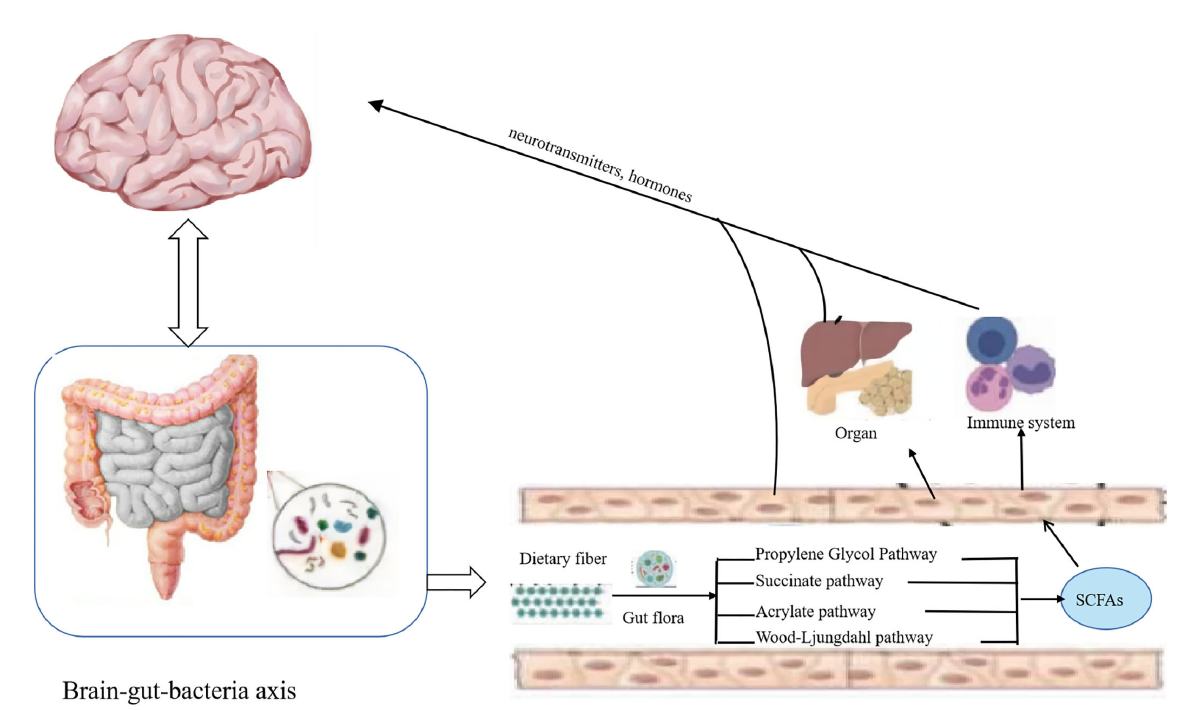
FIGURE3 Dietary fiber exerts its bioavailability through the brain–gut–bacteria axis. Short-chain fatty acids produced by the degradation of dietary fiber enter the hepatocytes and transform into small metabolic molecules with regulatory activities, break the blood–brain barrier and enter the central entry system, and play a regulatory role in the body by affecting the brain–gut–bacteria